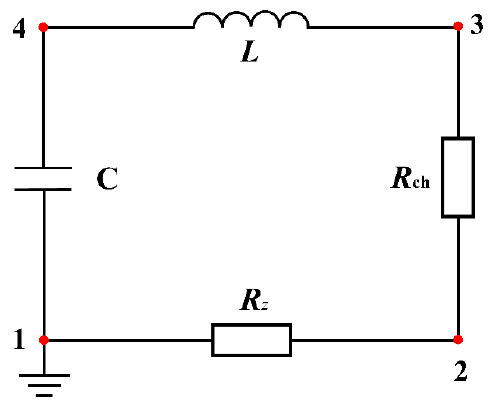
Figure 9. The RLC equivalent circuit for electric pulse in numerical simulation: R z —resistance of the discharge device; C —capacitor; L —inductive inductance; R ch —the equivalent resistance of the rock under electropulse.